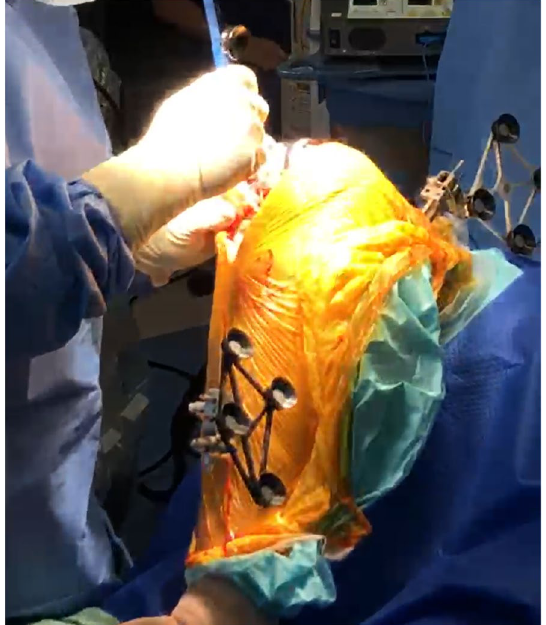
Fig. 4 Placement of femoral and tibial pin with arrays placed away from the knee incision